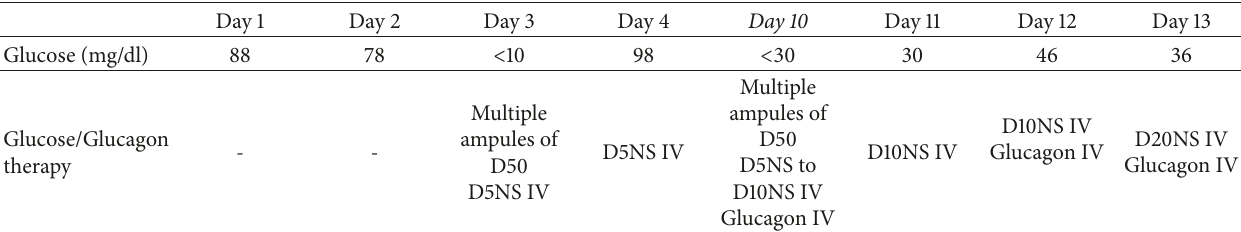
Table 2: Outline of pertinent lowest glucose levels throughout hospitalization along with correction measures